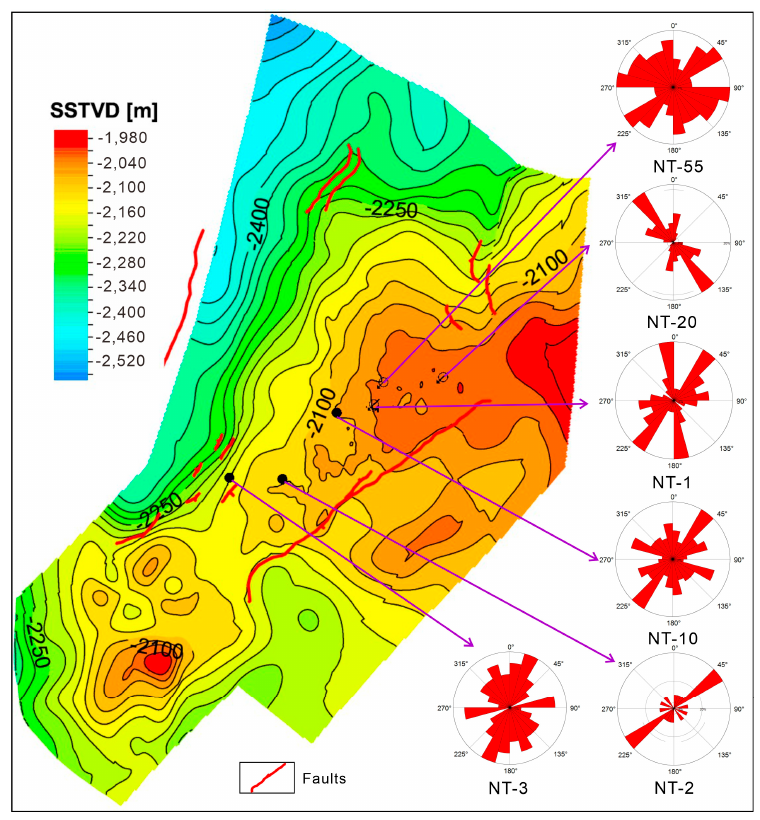
Figure 6. Strike of stylolites in the NT oilfield.